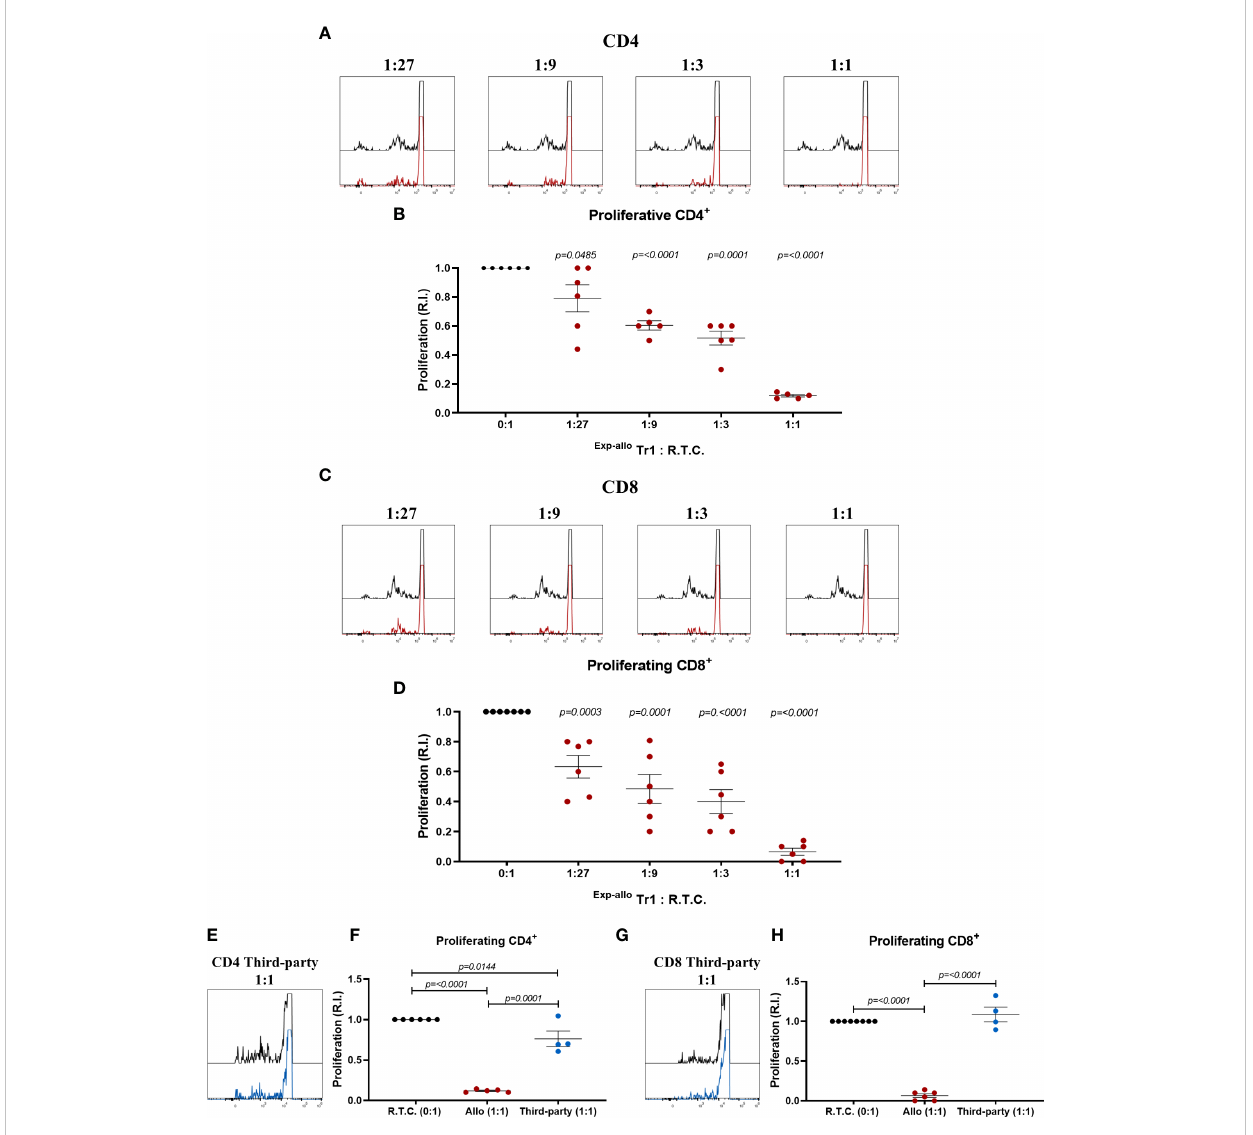
FIGURE 8 In vitro Exp-allo Tr1 cells suppress the proliferation of T conv cells in an alloantigen-speci fi c way. Exp-allo Tr1 were co-cultured with conventional CD3 + R.T.C. (labeled with CFSE) at different evaluated ratios and stimulated with allogeneic moDC from their respective donors or from non-related individuals (Third Party); on day 4 of culture, R.T.C. proliferation was evaluated by fl ow cytometry. (A – D) Exp-allo Tr1 inhibited the proliferation of both CD4 + (A, B) and CD8 + (C, D) R.T.C. at all evaluated ratios (n= 5-6). (E – H) Exp-allo Tr1 suppresses the proliferation of CD8 + (E, F) and CD4 + (G, H) R.T.C. cells only when they are stimulated with the allogeneic DCs with which they were initially expanded (Allogenic, red, n= 4-5), but do